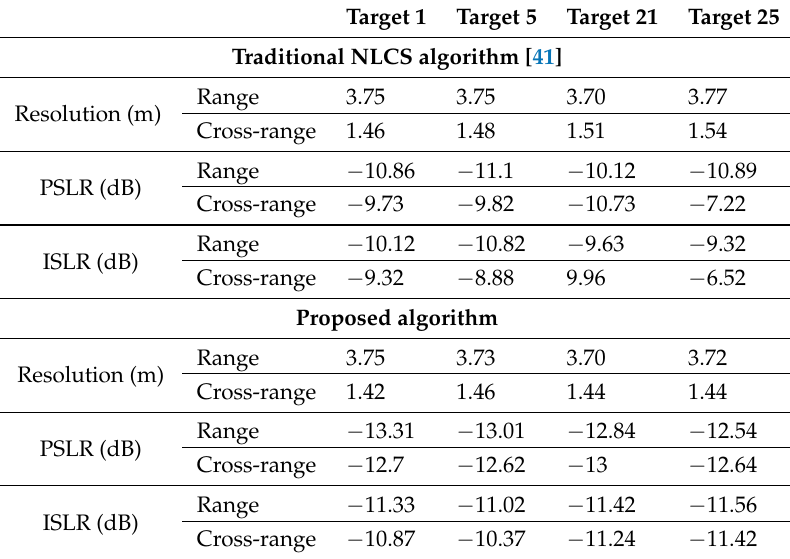
Figure 13. Simulation results of target 1 and target 25 in the range direction and the cross-range direction; ( a , b ) range direction results, ( c , d ) cross-range direction results. Table 2. Measured parameters of the selected